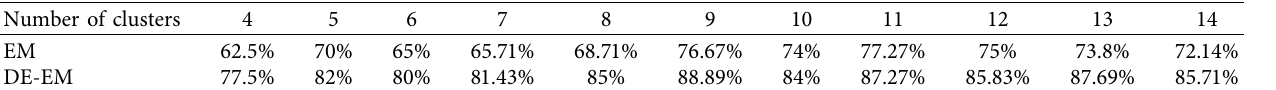
Figure 1: Performance comparison of the two algorithms. (a) Original distribution of the synthetic datasets; (b) EM-based clustering result and (c) DE-EM-based clustering result for the synthetic datasets. Table 2: Percentage of correct